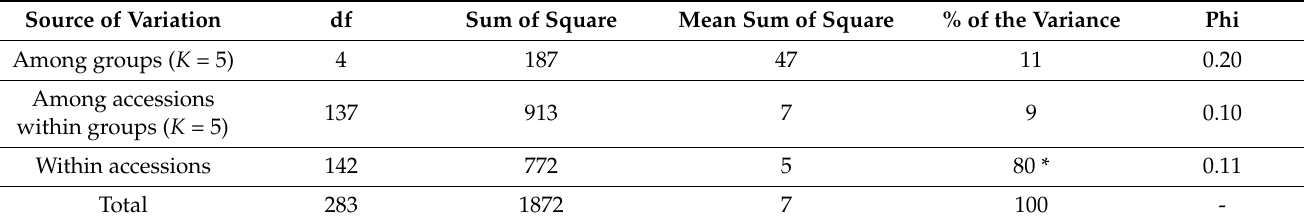
Table 2. Analysis of molecular variance (AMOVA) for 115 interspecific plum × apricot hybrids and 27 reference genotypes (diploid plums and apricots) structured in five groups ( K = 5). Source of Variation df Sum of Square Mean Sum of Square % of the Variance Phi